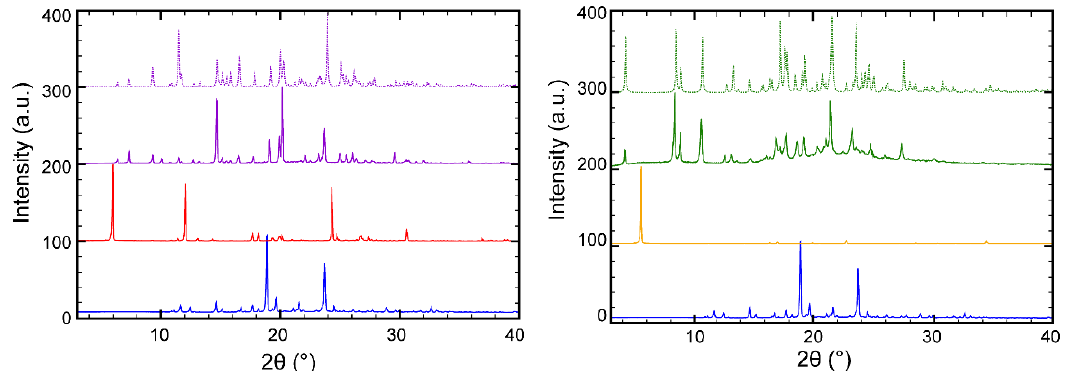
Figure 1. Powder X-ray diffraction (PXRD) patterns of benexate hydrochloride (BEX – HCl)